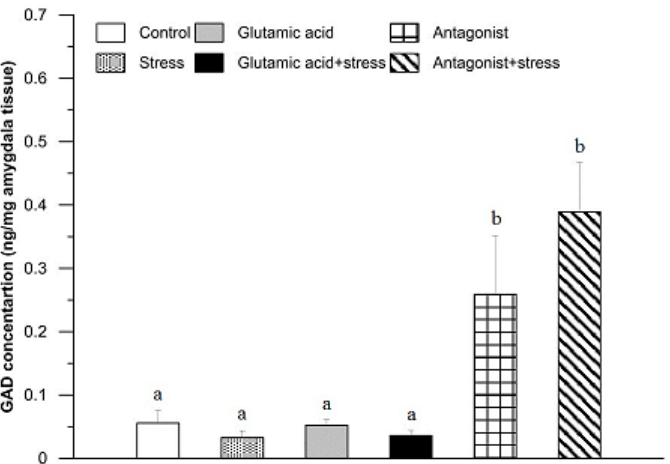
Figure 4. The effect of glutamic acid, stress, and glutamic acid receptor antagonist and their combinations with stress on the concentration of glutamic acid decarboxylase in the rabbit amygdala. For further explanations, see Figure 1.